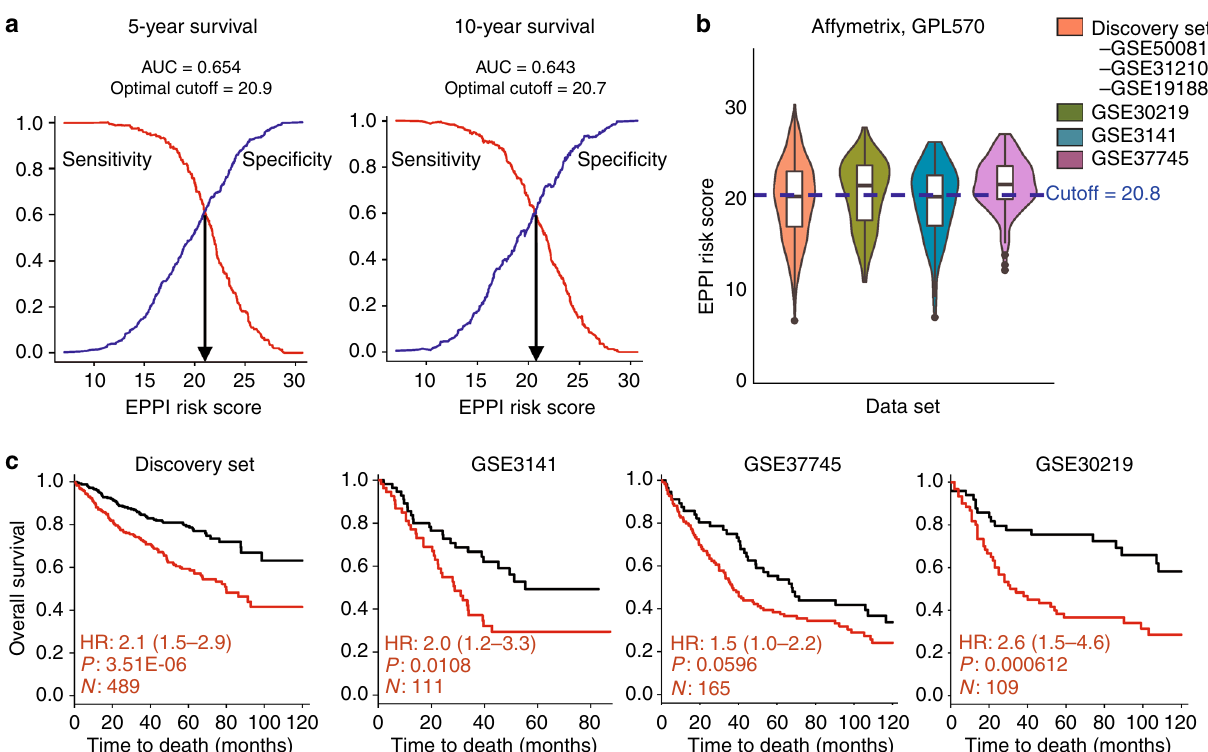
Fig. 5 Identi fi cation and validation of a common cutoff score using AUC analyses. a Time-dependent survival ROC curves at 5-year and 10-year from the discovery set are shown with best trade-off between sensitivity and speci fi city. b Violin plot depicting the score distribution in each data set probed with Affymetrix-GPL570 platform; a cutoff score of 20.8 was used to stratify patients into 2 groups. c Validation of prognostic performance in multiple data sets probed in Affymetrix-GPL570 platforms. The adjusted hazard ratio (HR), p -value ( P ), and the number of patients successfully strati fi ed ( N ) determined from univariate Cox regression analyses are shown on each survival KM curve. Black and red KM curves represent predicted low-risk and high-risk